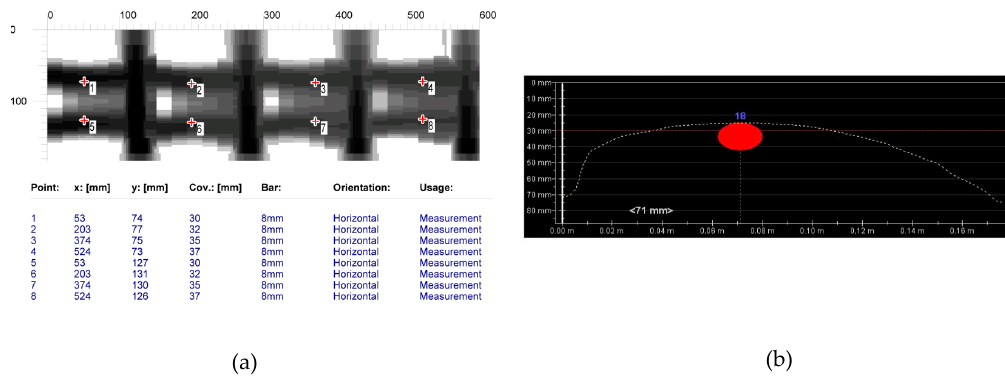
Figure 16. Scans taken with electromagnetic devices, ( a ) device 1, two rebars detected, average cover of visible results—33.6 mm, diameter 6-8 mm (measurement on the surface shown in Figure 10b), ( b ) device 2, one rebar detected, average cover of visible results—28 mm, diameter 18 mm (measurement at the point shown in Figure 11d)